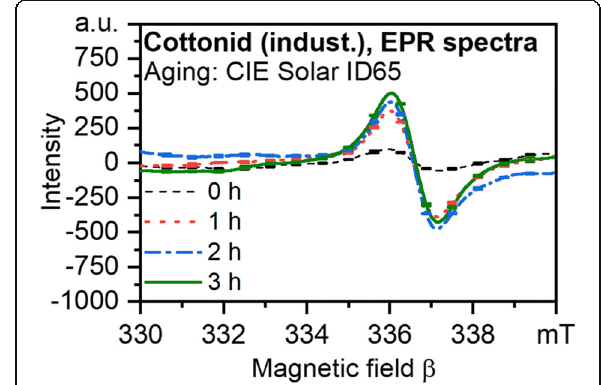
Fig. 6 Electron paramagnetic resonance (EPR) spectra of industrial Cottonid material (Ernst Krueger) in initial condition and after aging with standardized artificial solar irradiation (CIE solar ID65, irradiance: 2 kW/h) for increasing aging times